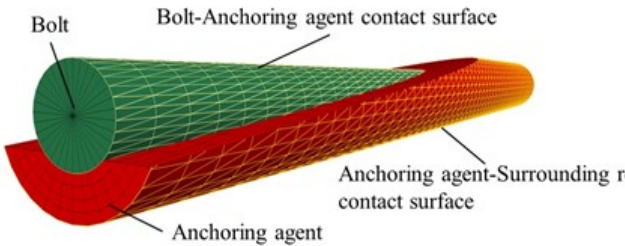
Figure 2. FLAC 3D schematic diagram of the contact surfaces of the bolt, anchoring agent, and surrounding rock.